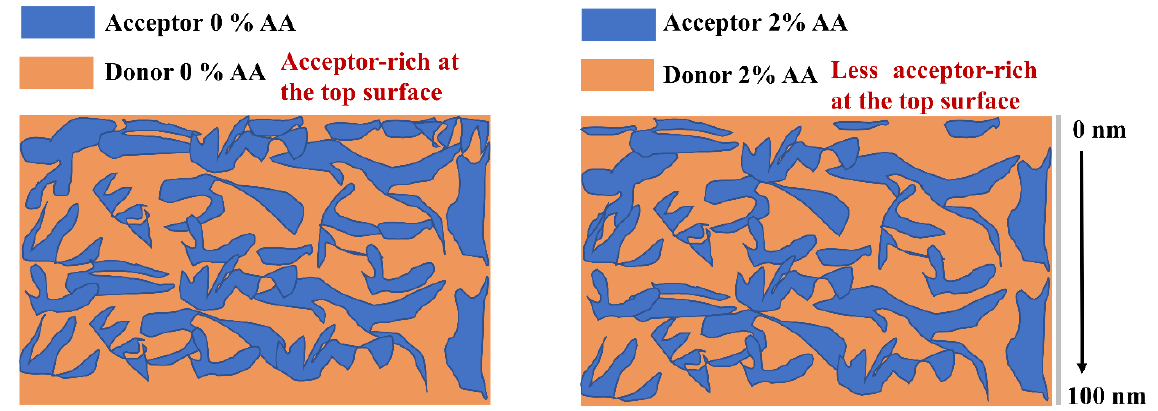
Figure 4. The schematic shows the effect of the AA additive on the donor enrichment at the surface.